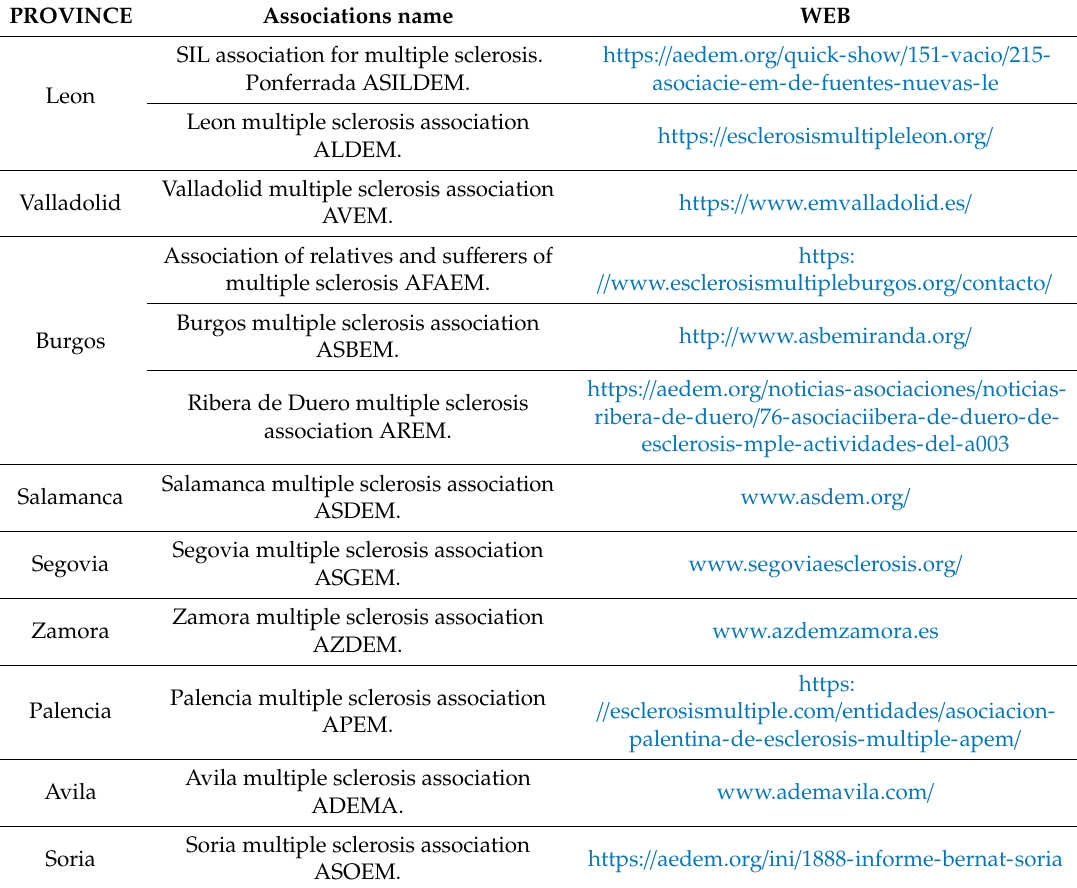
Table 1. Multiple sclerosis associations of the Castilla y Le ó n region